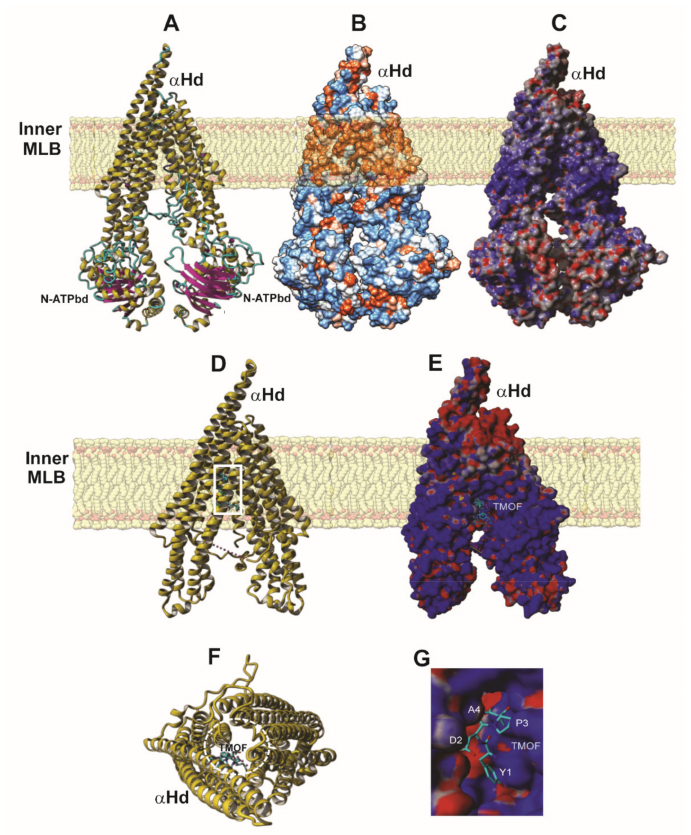
Figure 7. Three-dimension molecular model presentation of Aea ABC-TMOF receptor. ( A ) Ribbon diagram of the V-shaped three-dimensional model of Aea ABC-TMOF receptor. The intracellular ATP-binding domains (ATPbd) located at the bottom of the model are associated with the intracellular α -helical domain ( α Hd), that partly protrudes out of the cell surface. ( B ) Hydrophilic (colored blue) and hydrophobic (colored orange) patches distributed on the molecular surface of Aea ABC-TMOF receptor. The hydrophobicity of the α -helices allows the receptor to embed in the membrane lipid bilayer (MLB). ( C ) Surface electrostatic potential regions distributed on the molecular surface of the Aea ABC-TMOF receptor that are electronegatively and electropositively charged are colored red and blue, respectively. Neutral regions are colored grey. ( D ) Ribbon diagram showing Aea TMOF (colored green) docked into the binding site located at the fork of α helical binding domain ( α Hbd). Dotted pink line shown in D and F, indicates that in these graphical presentations of the Aea ABC-TMOF receptor the N-ATPbd of the molecule is missing. ( E ) Surface exposed electrostatic potentials of the α Hd showing a single docking position of TMOF (colored cyan) at its binding site. Electronegative and electropositive charged regions are colored red and blue, respectively, and the neutral regions are colored grey. ( F ) Upper front view of the α Hd containing a single docking position of TMOF (colored cyan), showing the open space across the α -helices and loops (dashed white open circle) at the top of the α Hd that allows TMOF to enter and bind inside the binding cavity. ( G ) Enlargement of (E) showing the binding of TMOF (colored cyan) in the binding cavity in the α Hd of Aea ABC-TMOF receptor. Several of the amino acids of TMOF are in white